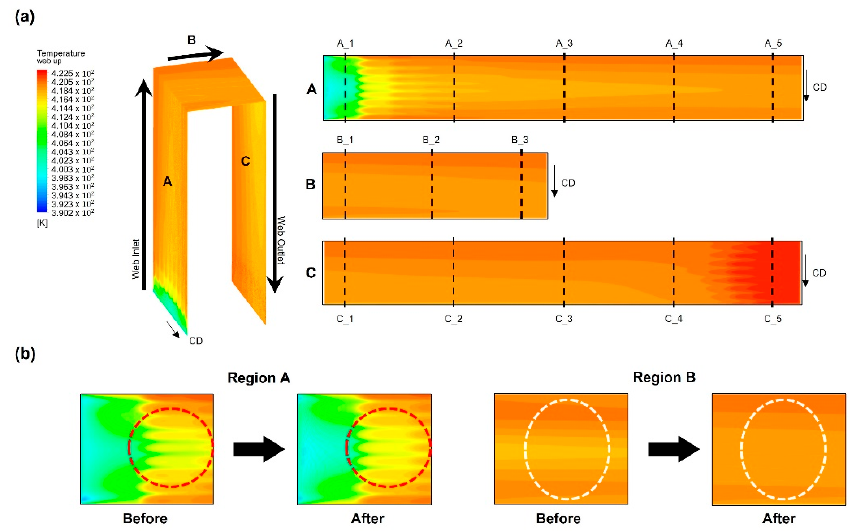
Figure 9. Improvements in the flow channel to achieve a uniform temperature distribution.